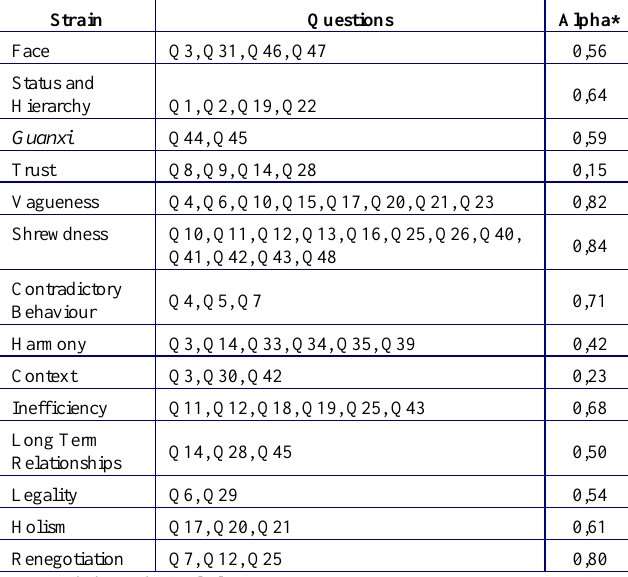
Table 1: Ranking of statements that best describe the Chinese negotiator